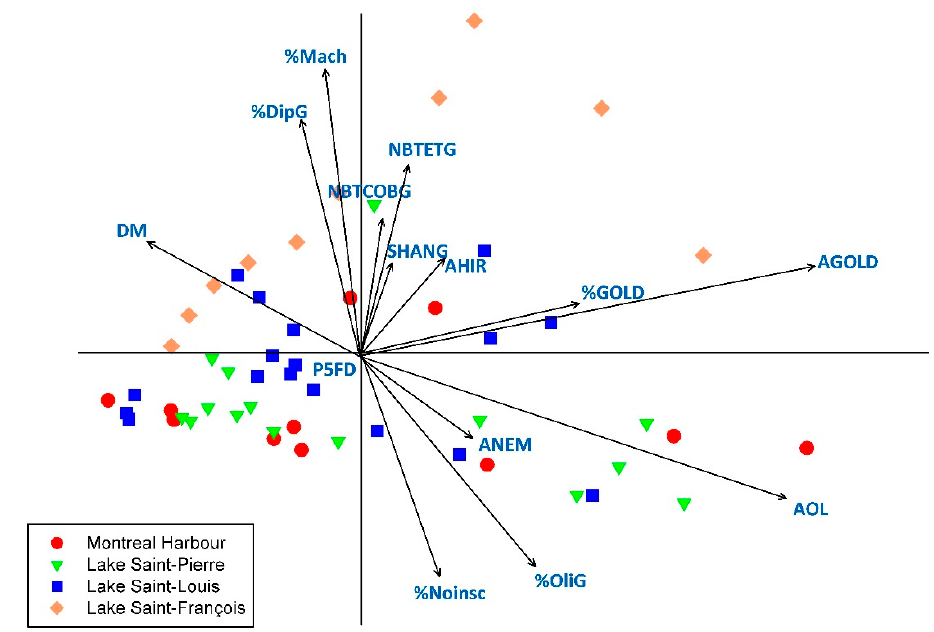
Figure 3. Principal component analysis showing the projection of the vectors of the 14 final indices and metrics and the ordination of the sampling sites of each habitat zone of the fluvial section (without 2 outliers of LSL sites).